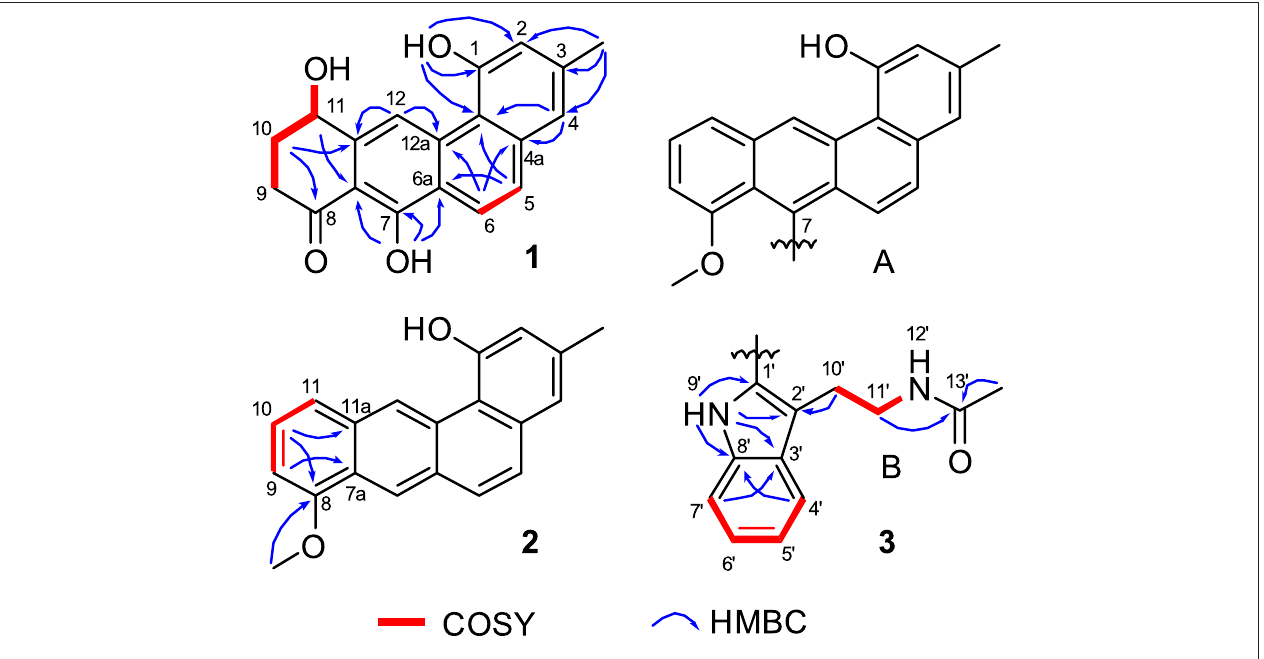
FIGURE 2 | Selected HMBC and 1 H − 1 H COSY correlations of 1, D-ring in 2, and N -acetyltryptamine motif in 3.